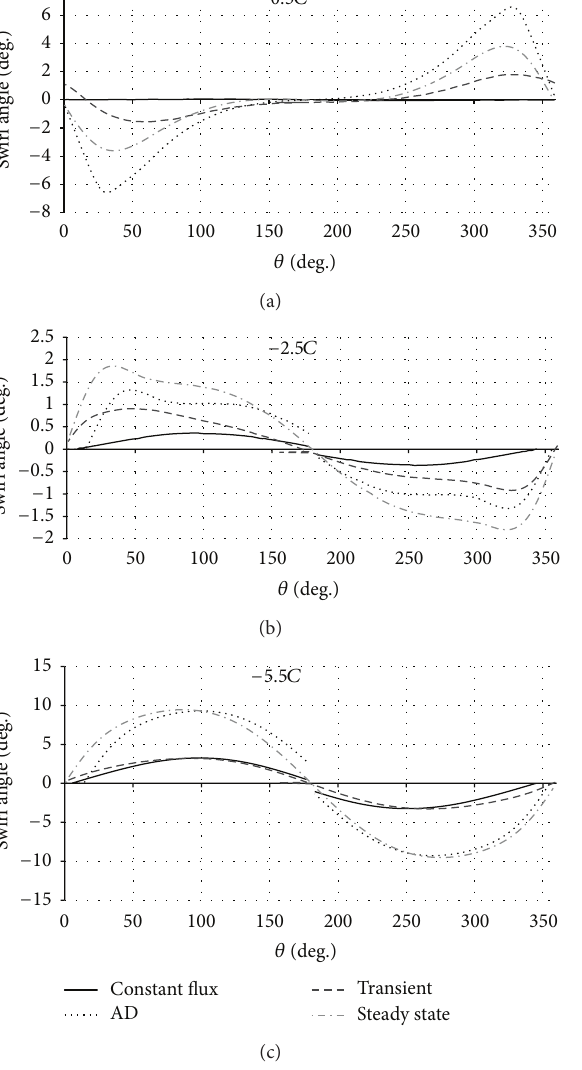
Figure 24: Swirl angle